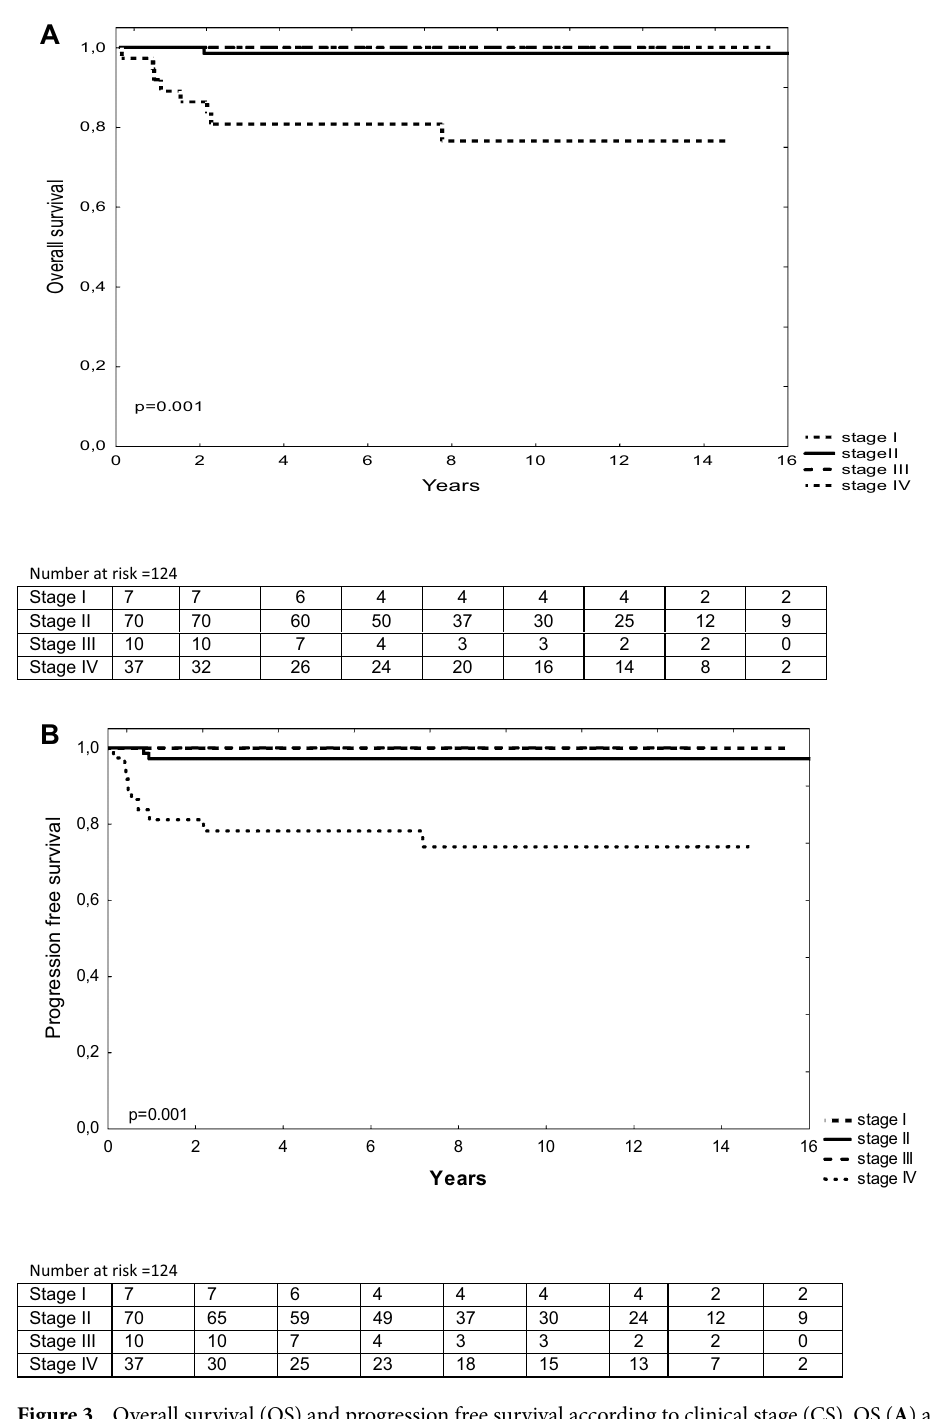
Figure 3. Overall survival (OS) and progression free survival according to clinical stage (CS). OS ( A ) at 5 year was 100% for CS I, 98% for CS II, 100% for CS III and 78% for CS IV. PFS ( B ) at 5 year was 100% for CS I, 98.5% for CS II, 100% for CS III and 81% for CS